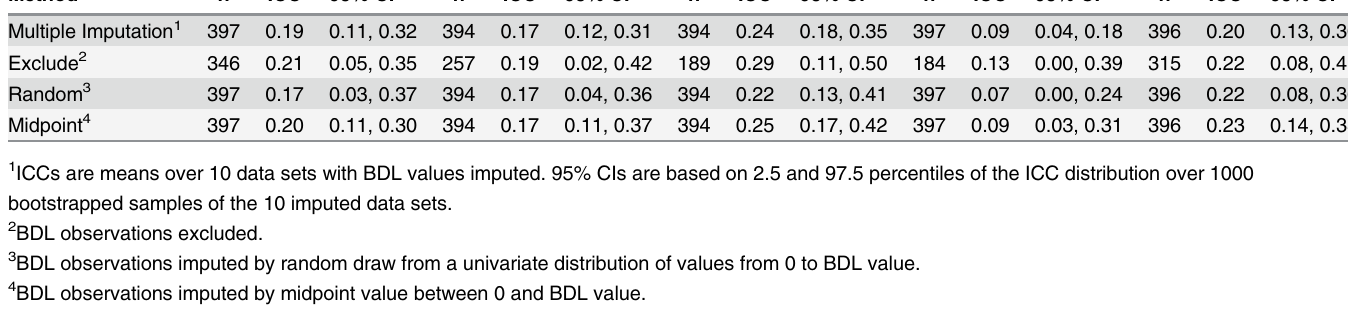
to parous women and in NAF producers compared to non-NAF producers, and progesterone ICC was higher in NAF producers compared to non-NAF producers. Within-subject ICCs by analytical method for dealing with BDL observations are shown in Table 5. Predictably, ICC point estimates were most affected by method for the two analytes with the highest percentage of BDL observations, estradiol and estrone sulfate, but overall there was little effect of method on ICC point estimates. For all analytes, correlation among analyte levels measured within the same lobe over two visits was virtually zero (data not shown).